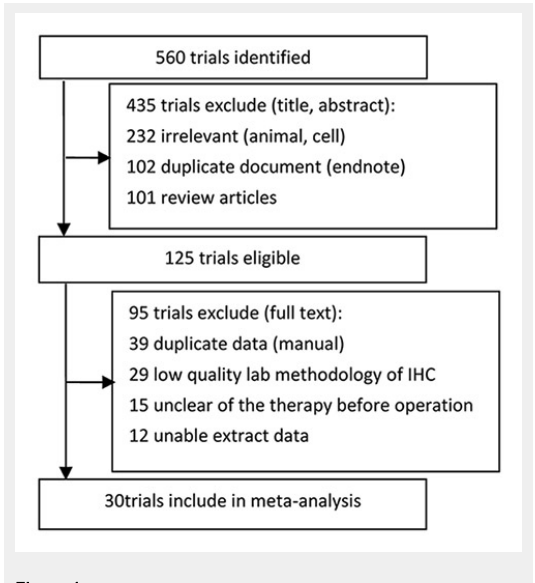
Forest plot of VEGF, CA IX and bcl-2 positive expression in positive and negative HIF-1α tumour tissues, respectively (Giatromanolaki A 01 2001: Giatromanolaki A 2001 [14], Giatromanolaki A 2001: Giatromanolaki A 2001 [15], Swinson 01 2004: pCA IX, Swinson 02 2004: mCA